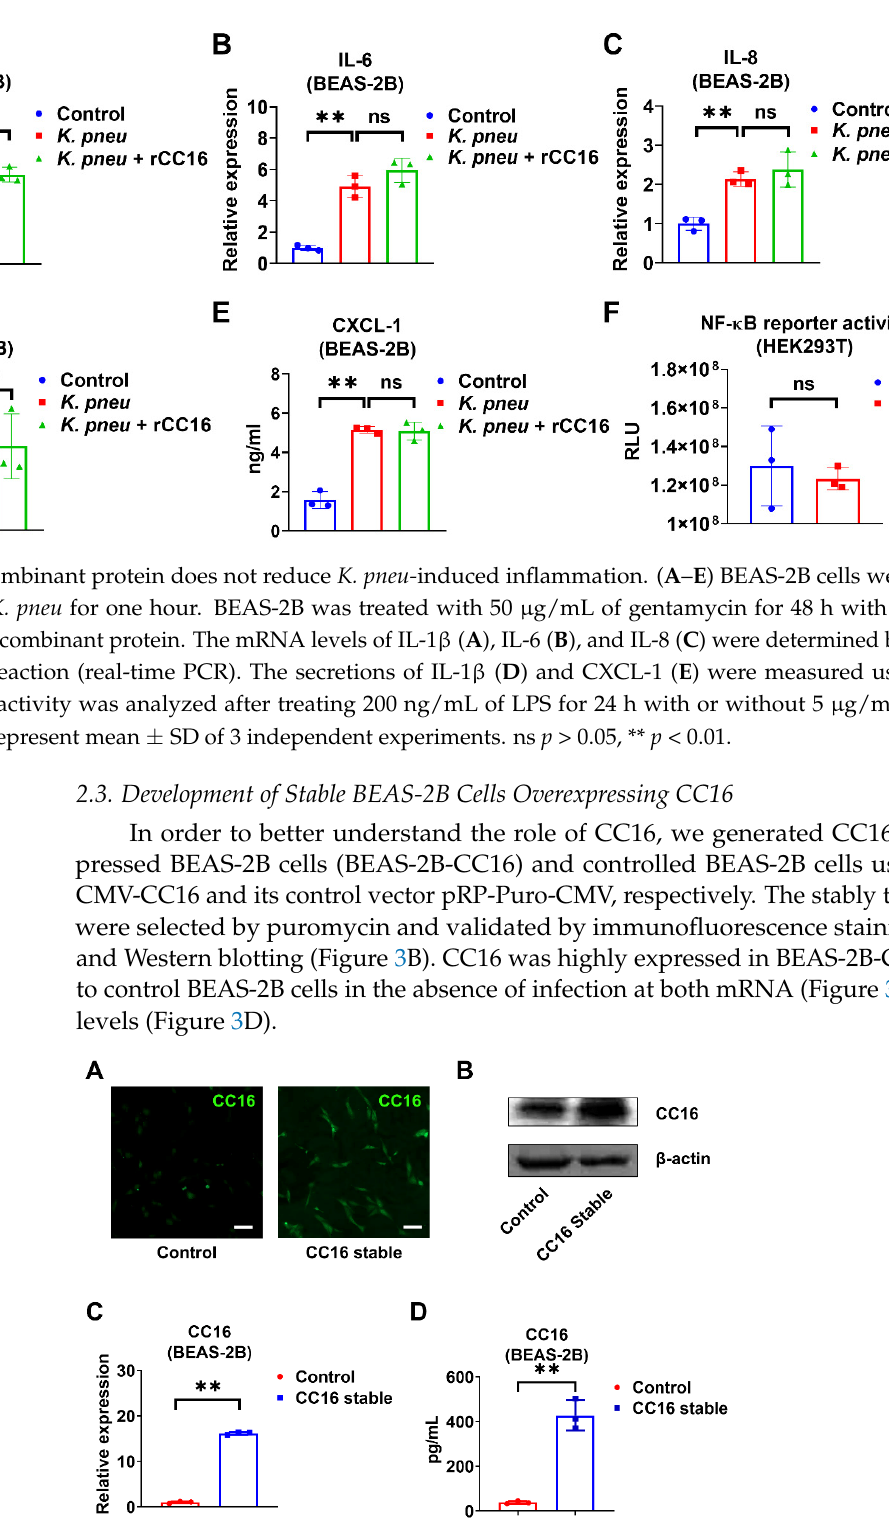
Figure 3. Development of stable BEAS-2B cells overexpressing CC16. ( A ) Immunofluorescence staining images of CC16 were captured in control BEAS-2B and BEAS-2B-CC16. ( B ) The protein expression of CC16 was analyzed by Western blot. ( C ) The mRNA levels of CC16 in BEAS-2B and BEAS-2B-CC16 were measured by real-time PCR. ( D ) The protein levels of CC16 in BEAS-2B and BEAS-2B-CC16 were analyzed by ELISA. Scale bars, 100 µ m. Results represent mean ± SD of 3 independent experiments. ** p <